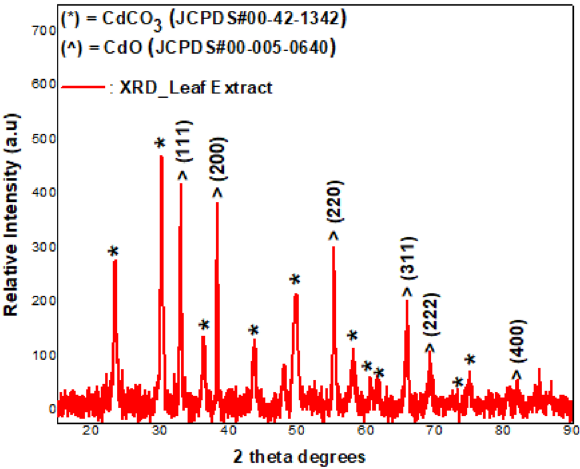
Figure 2. XRD of CdO/CdCO 3 in the un-annealed state, synthesised using S. cupulare leaf extract.